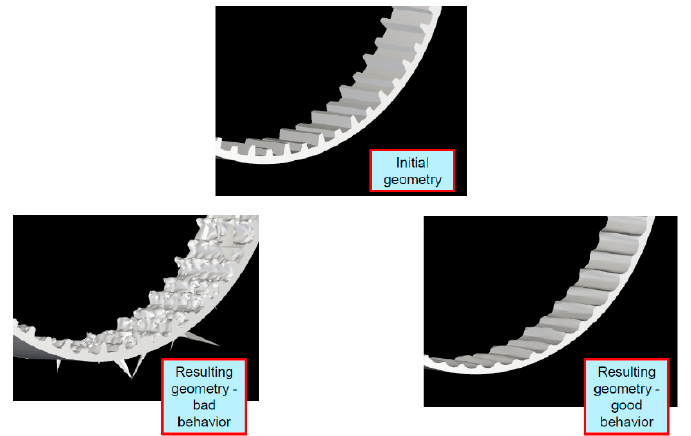
Figure 7. Effect of boundary definition and mesh refinement in the obtained wear pattern [29].